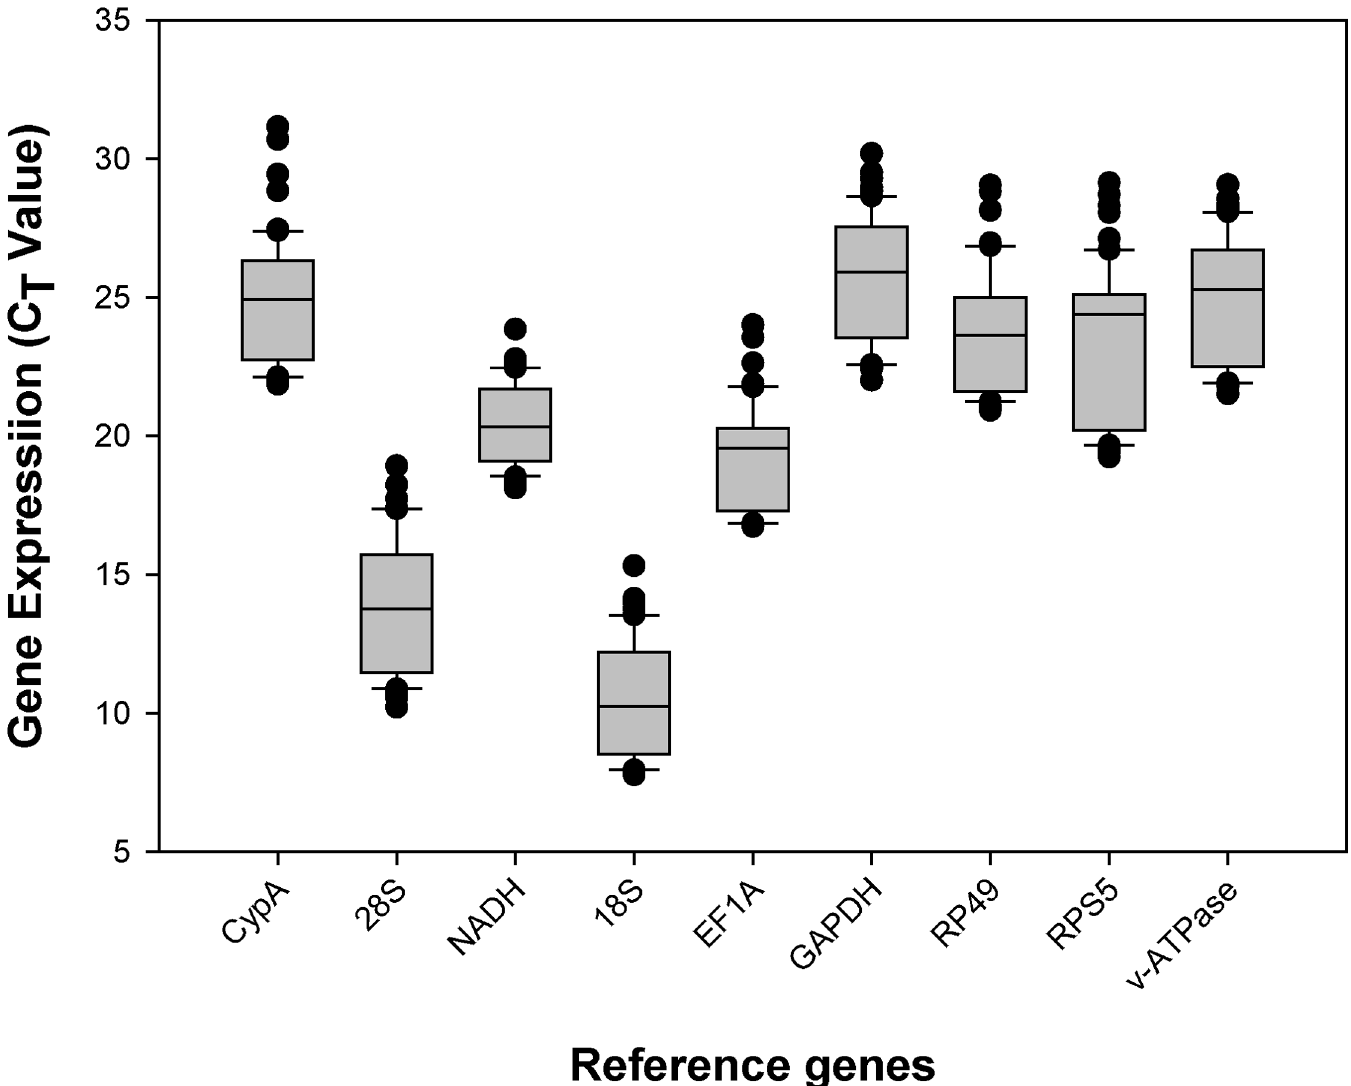
Fig 1. Expression profiles of candidate reference genes in D . plexippus . The expression level of candidate reference genes in 60 tested samples are documented in C t -value. The dot indicates the maximum or minimum value of replicated samples, while whiskers indicate the standard error of the mean.